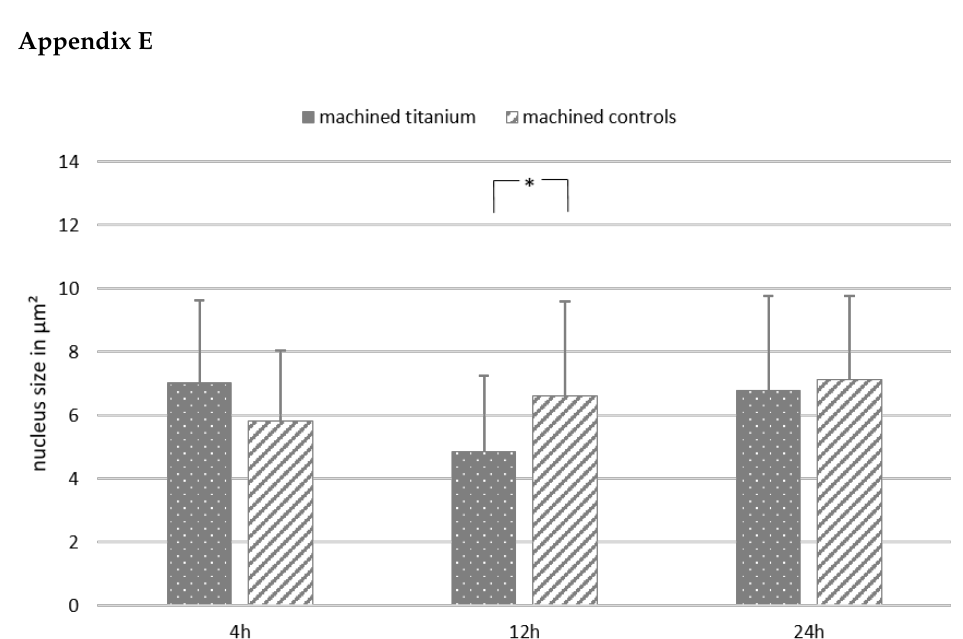
Figure A5. Comparison of the nucleus size after 4, 12 and 24 h of cultivation of machined titanium probes with controls. The bars correspond to the mean value, the line on top to the ± standard deviation. Statistically significant differences ( p < 0.05) are marked with an asterisk.